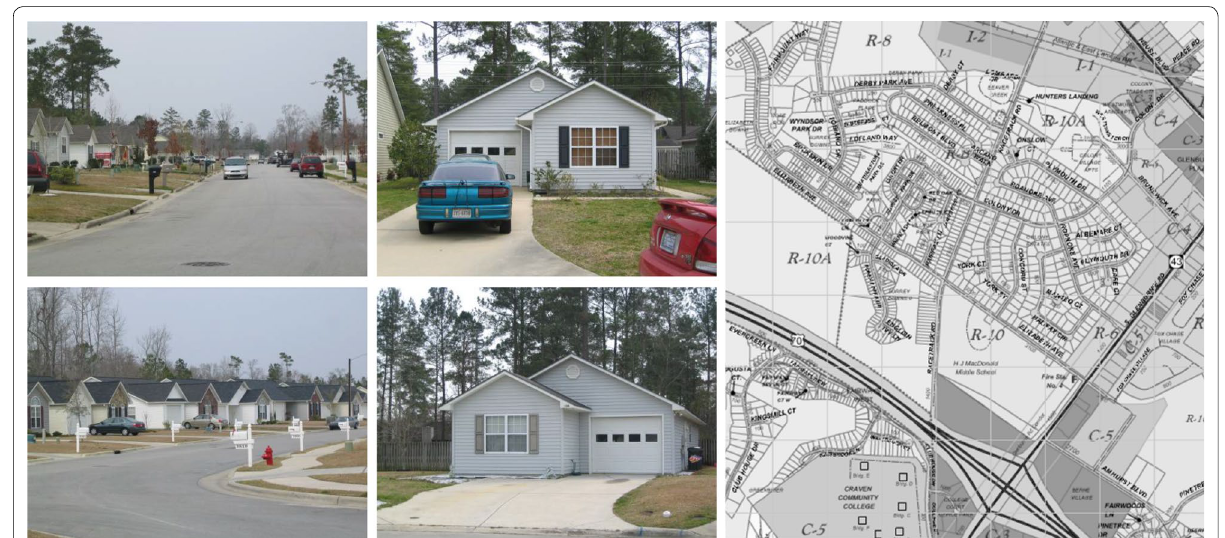
Fig. 9 Low-to-mid-scale residential subdivisions and street